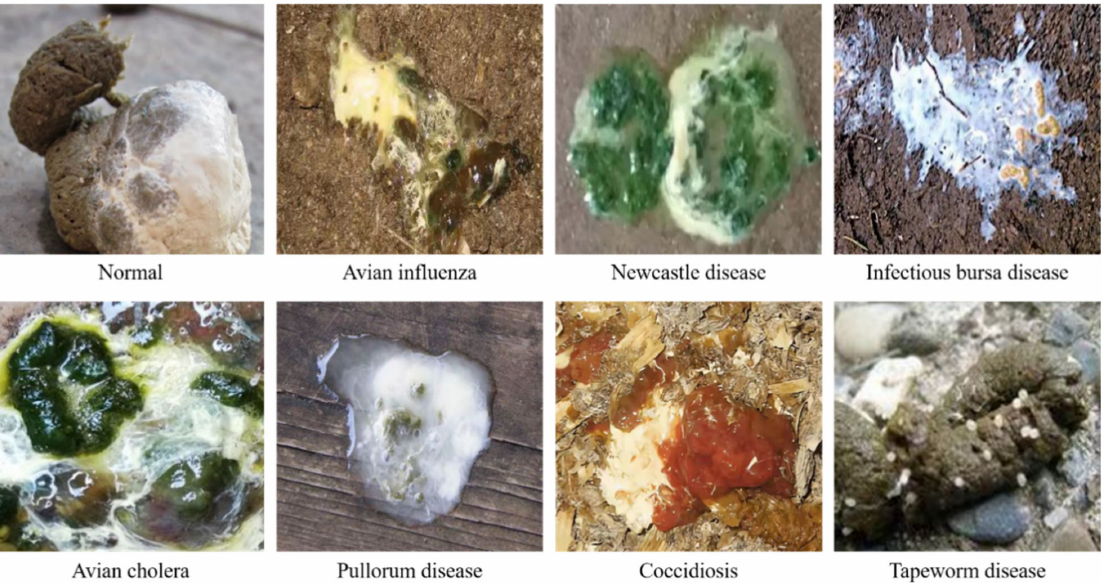
Figure 4. The normal and abnormal feces from typical digestive diseases in chickens. The feces of disease-infected chickens may have abnormal changes in color, shape, water content and contents. Therefore, feces can be used as the basis for the early warning of chicken diseases.